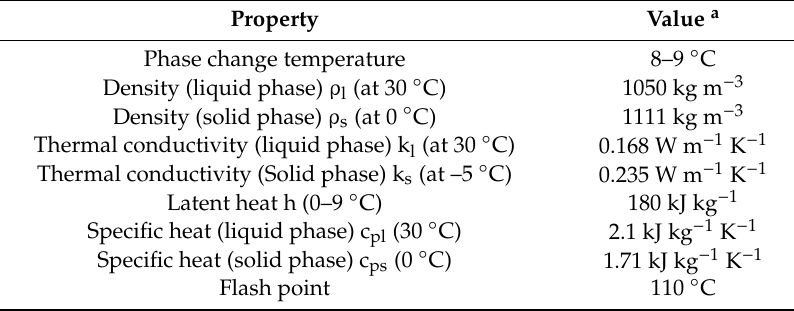
Table 2. Thermo-physical Properties of OM 08.